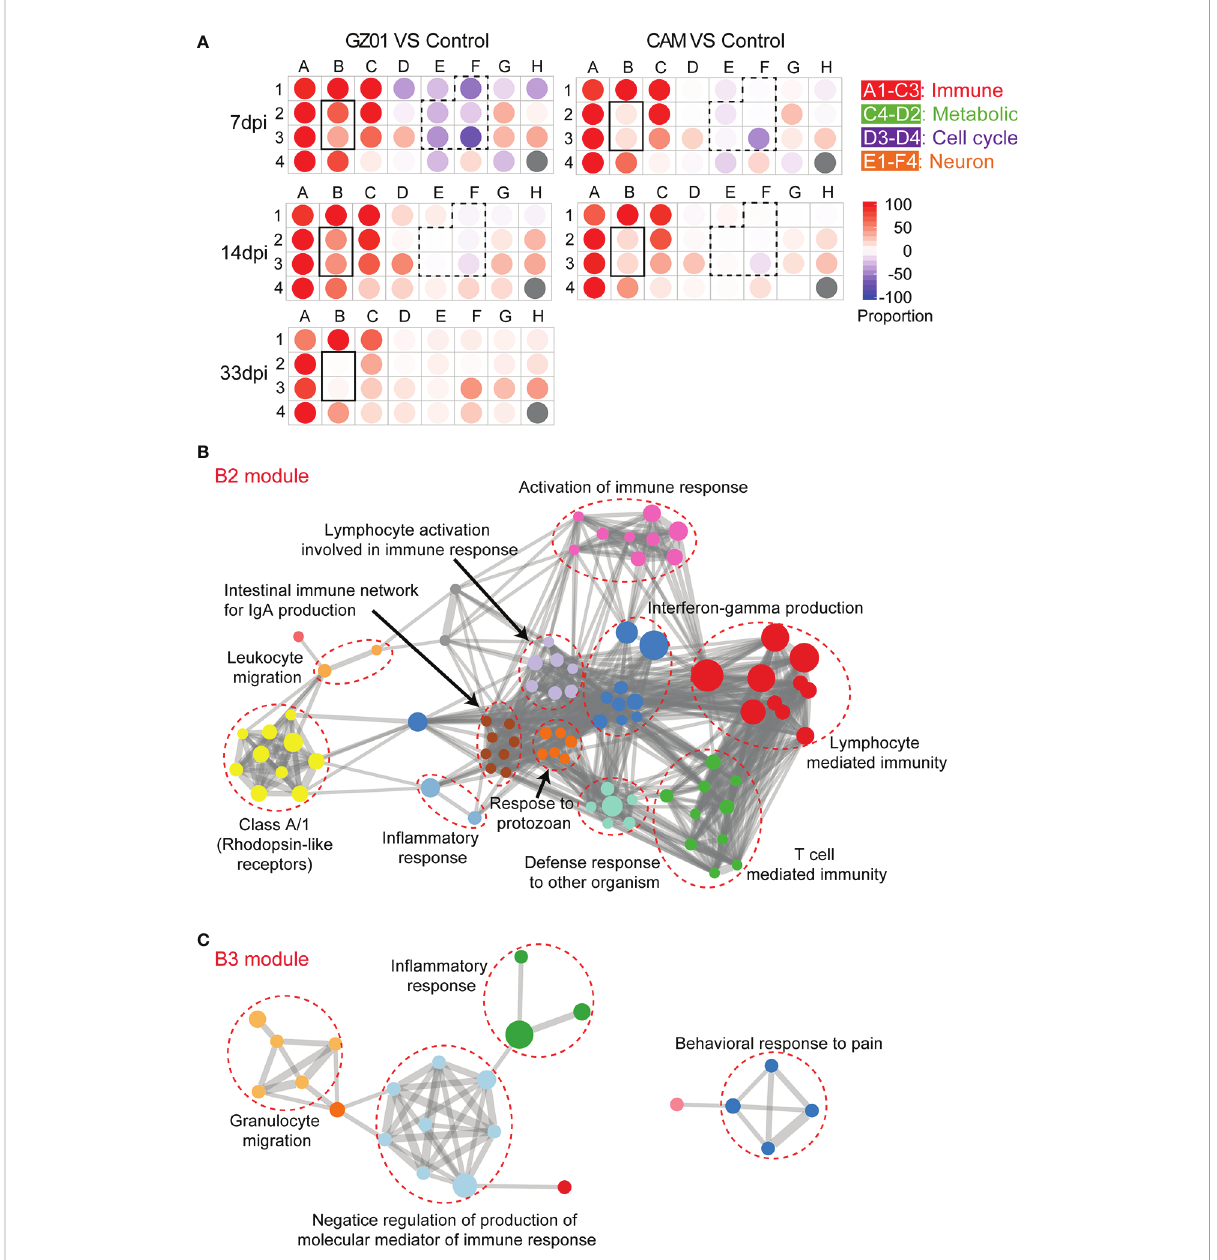
FIGURE 2 Identify key difference modules between CAM and GZ01 infected mice. (A) , Modular map analysis: Gene expression from mice infected with CAM and GZ01 and Control mice were compared (P < 0.05, Fold change > 1.5). Spots indicate the proportion of genes signi fi cantly that were changed for each module in mice infected with CAM and GZ01 compared to controls. Red: Overexpressed, Blue: Underexpressed. ( B, C ), Network of enriched terms of the B2 and B3 modules, colored by cluster ID, where nodes that share the same cluster ID are typically close to each